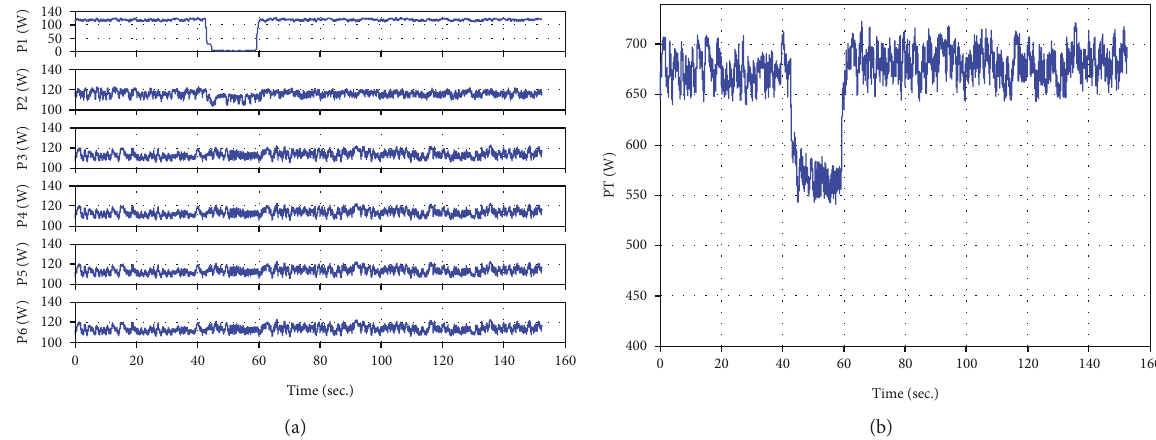
Figure 19: (a) Distributed MPPT control of all PV modules under shading. (b) Total power extracted from the whole PV modules.